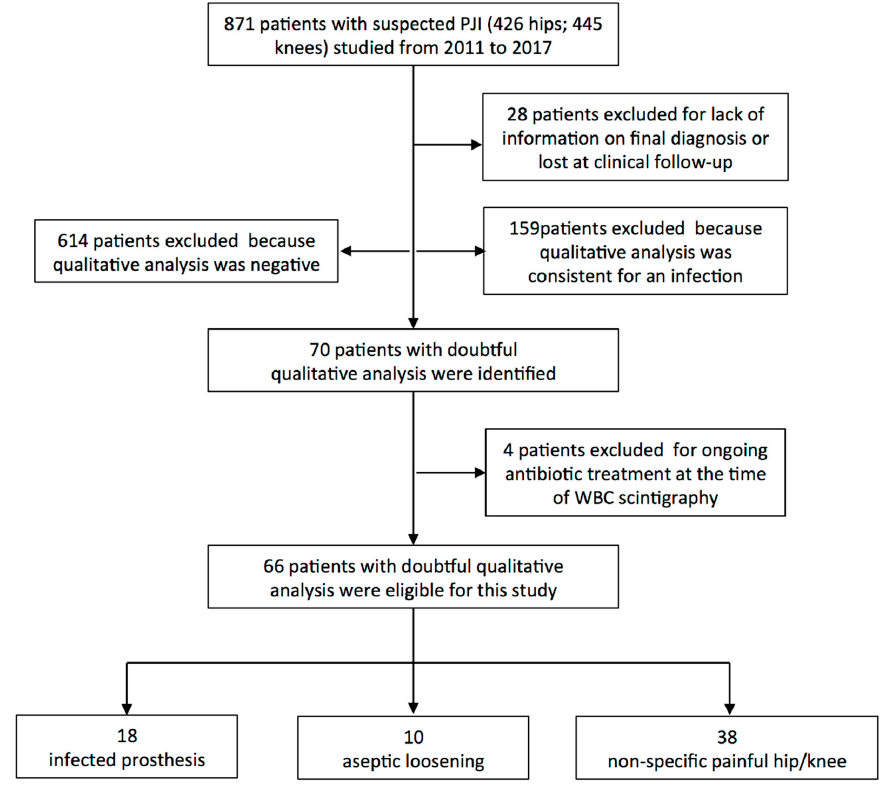
Figure 2. Flowchart of patients included in the study.